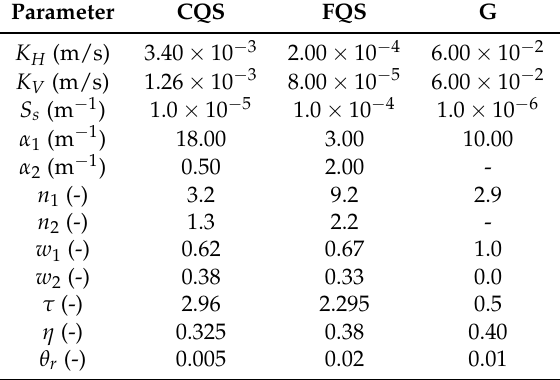
Table 1. Soil parameters for three different materials: coarse quartz sand (CQS), fine quartz sand (FQS), and gravel